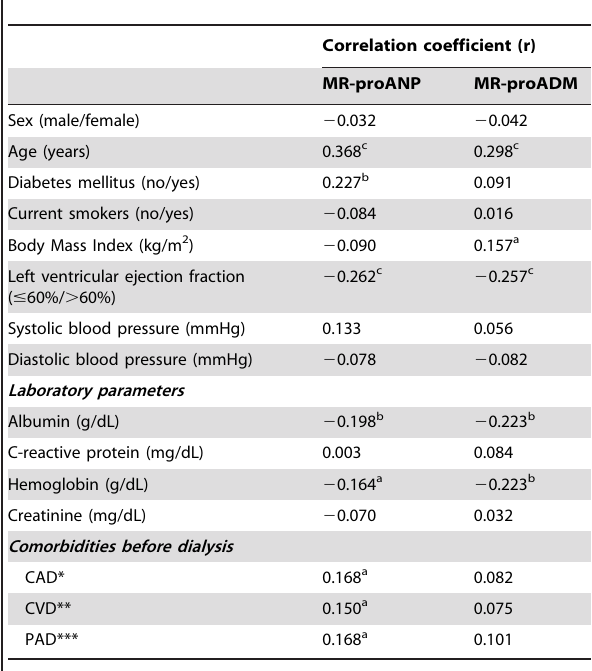
natriuretic peptide (MR-proANP) and mid-regional pro- adrenomedullin (MR-proADM) and different